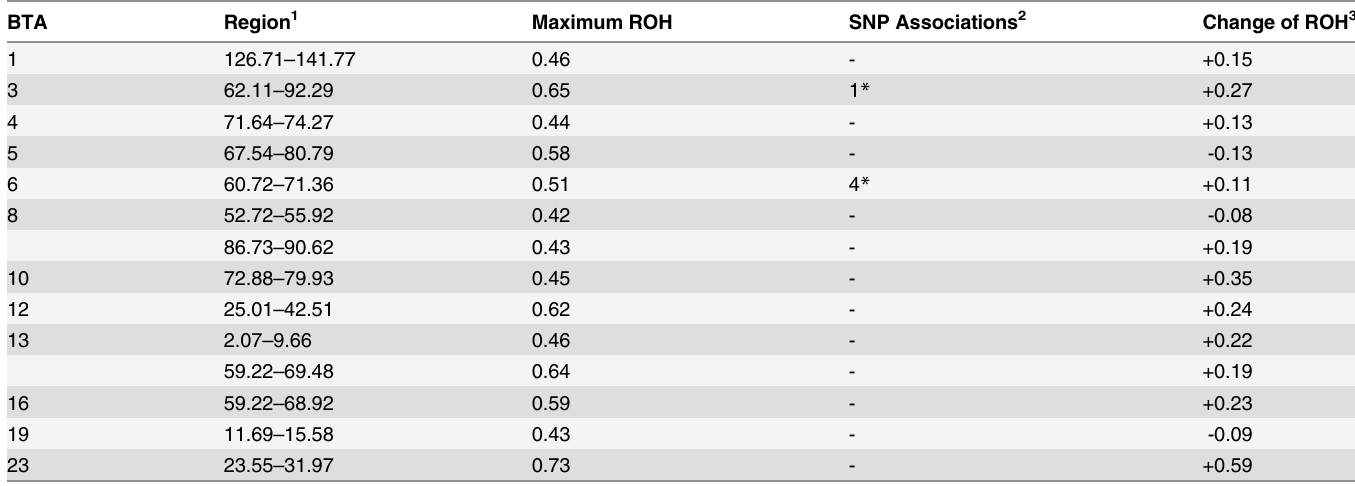
Table 4. Summary of genomic regions with ROH >